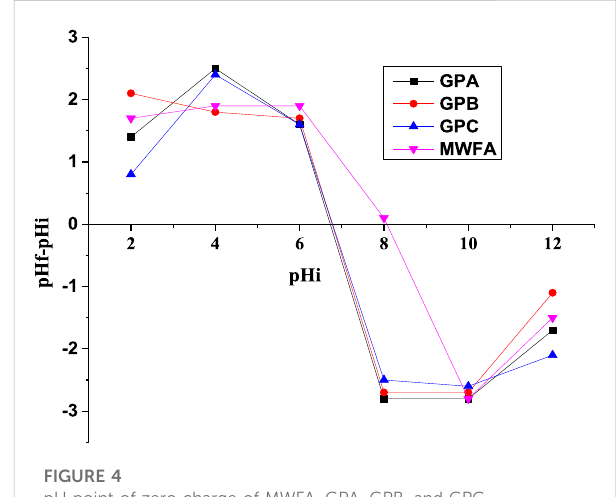
FIGURE 4 pH point of zero charge of MWFA, GPA, GPB, and